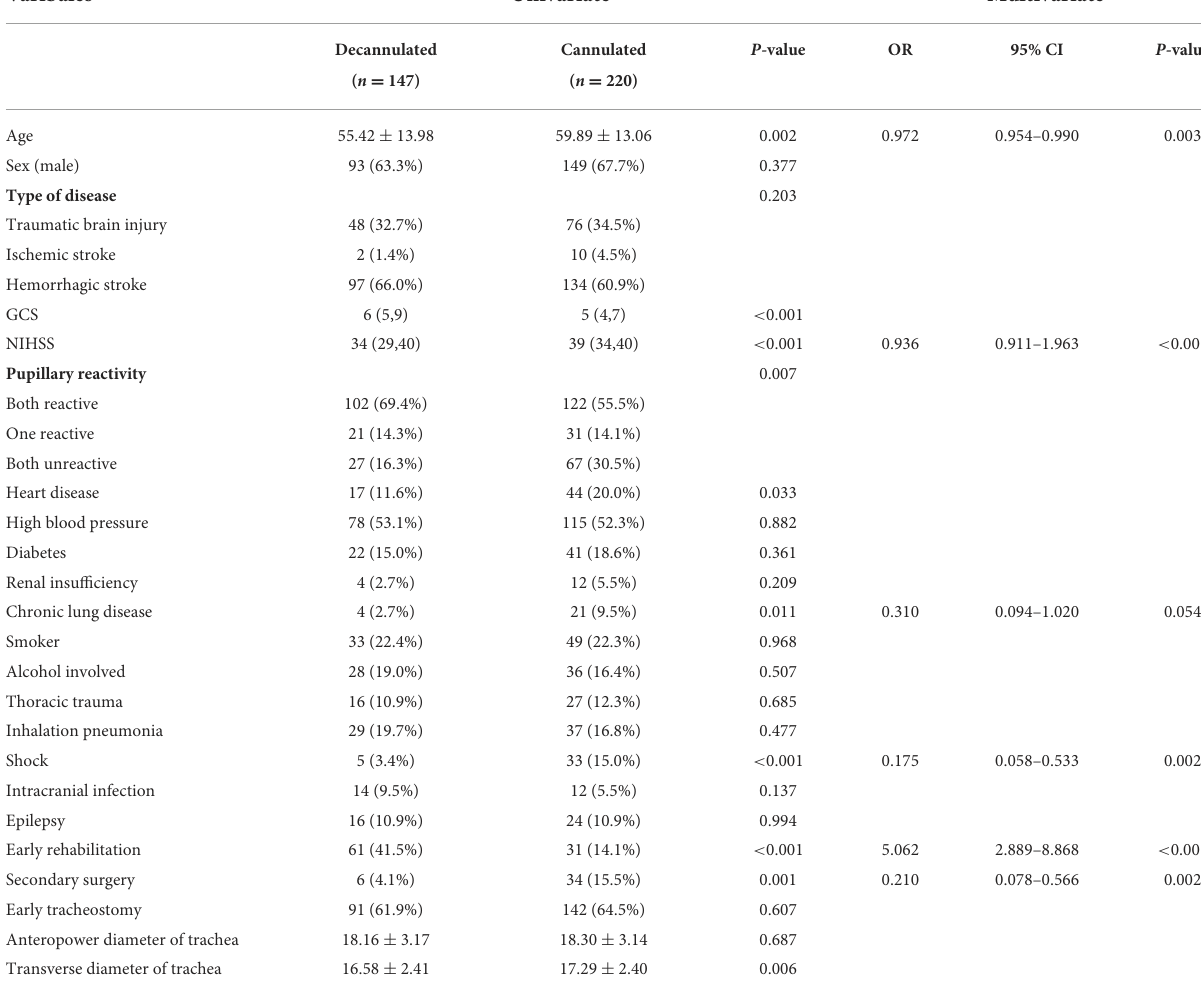
TABLE 1 Univariate and multivariate logistic regression analyses of patients decannulated within 6 months. Varibales Univariate